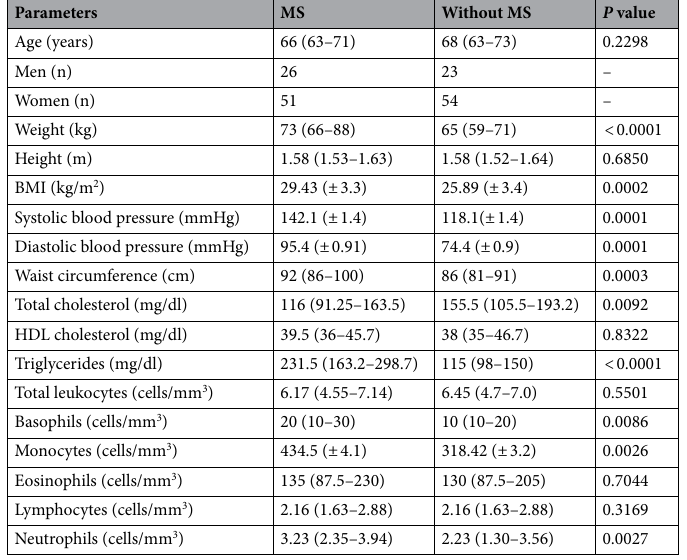
Table 1. Clinical and anthropometric characteristics of older adults with and without MS (n = 77 each in the MS and ‘without MS’ groups). MS metabolic syndrome. Mean (± Standard deviation), Median